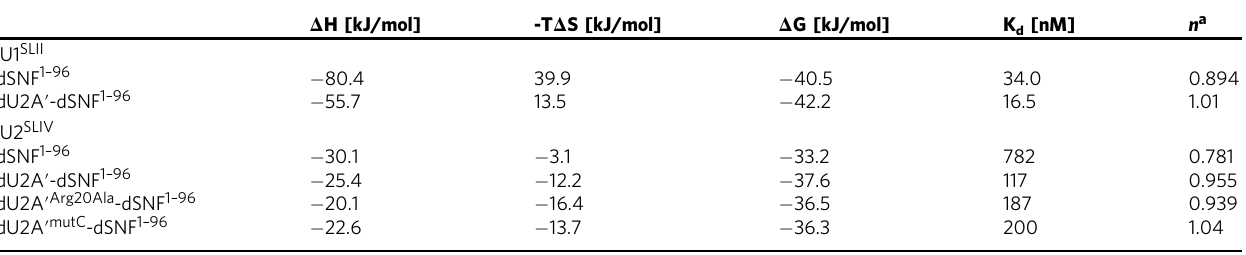
Table 1 Thermodynamics of RNA